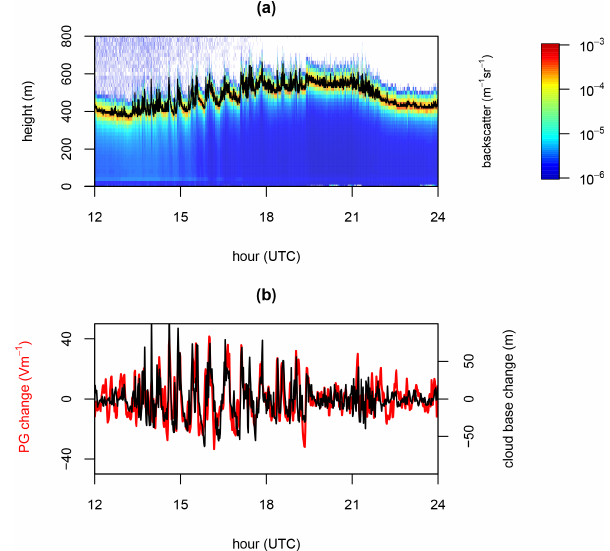
Figure 5. Measurements from Reading University Atmospheric Observatory on 19 March 2015 showing (a) ceilometer backscatter from cloud base (at 400 to 500m) and (b) fluctuations in the atmo- spheric electrical potential gradient (PG, thick red line) and cloud base height (thin black line). (Adapted from Harrison et al.,